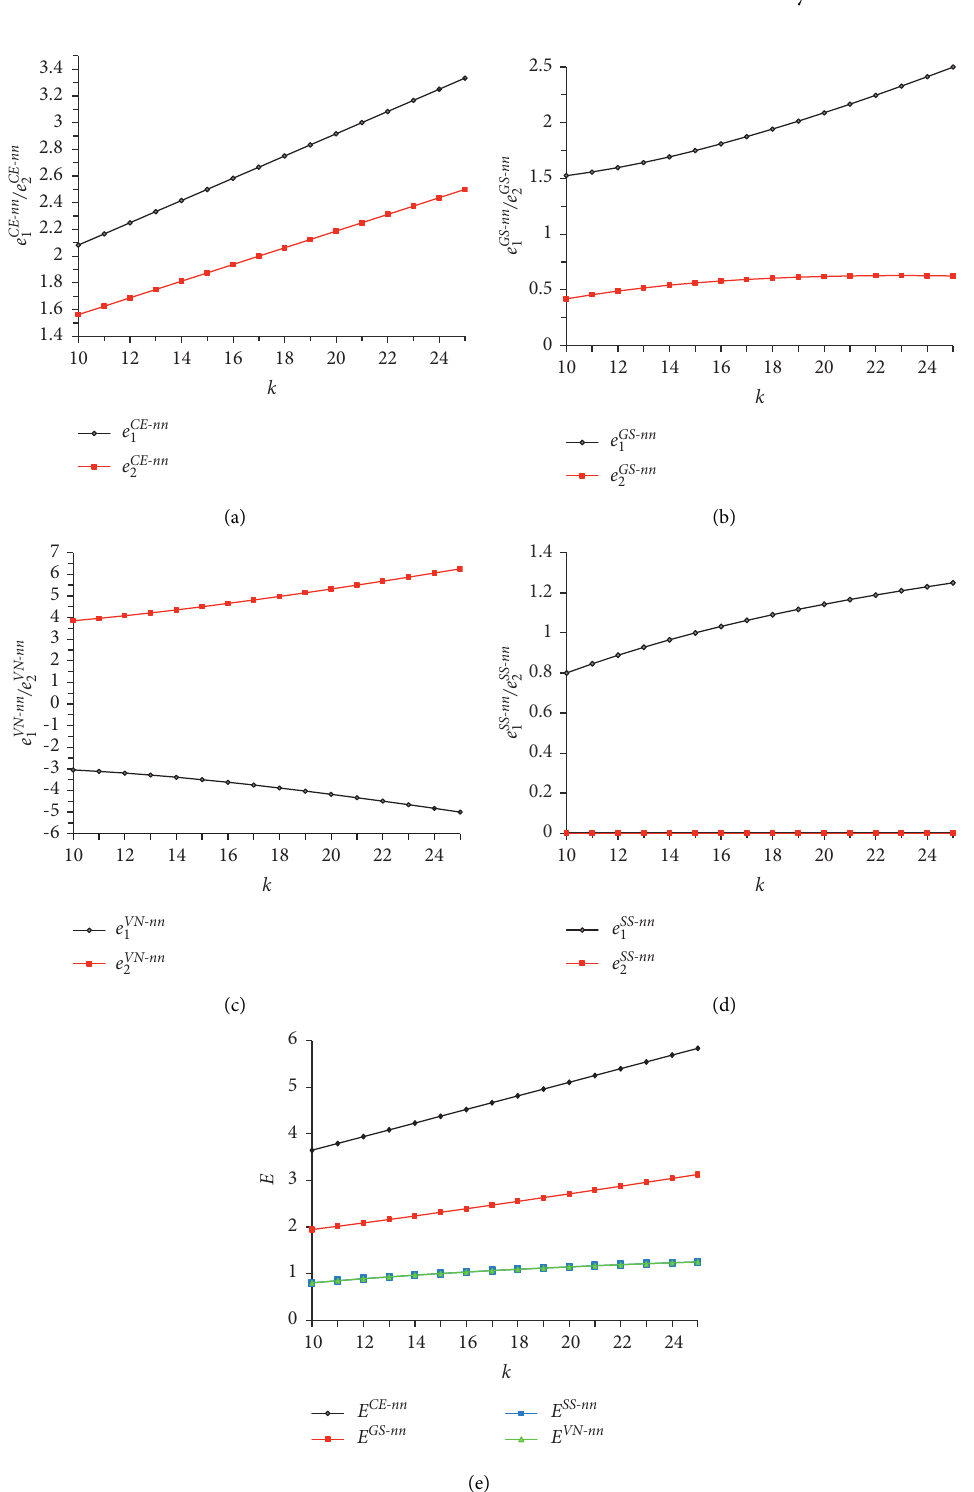
Figure 1: Effects of k on emission reduction